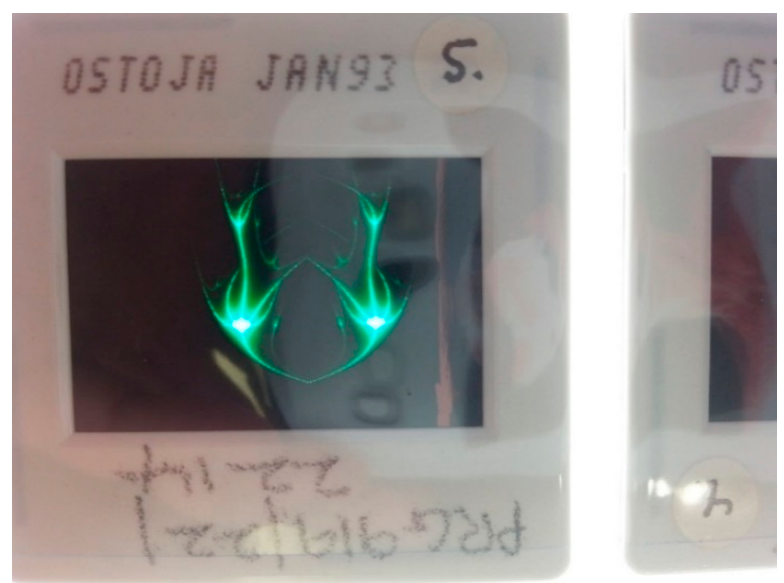
Figure 27. Close-up of computer-generated imagery that would be combined with the landscape in Figure 29. SLSA: PRG919/22/1981-2004. Image courtesy Maria Garda. Published with permission of SLSA.